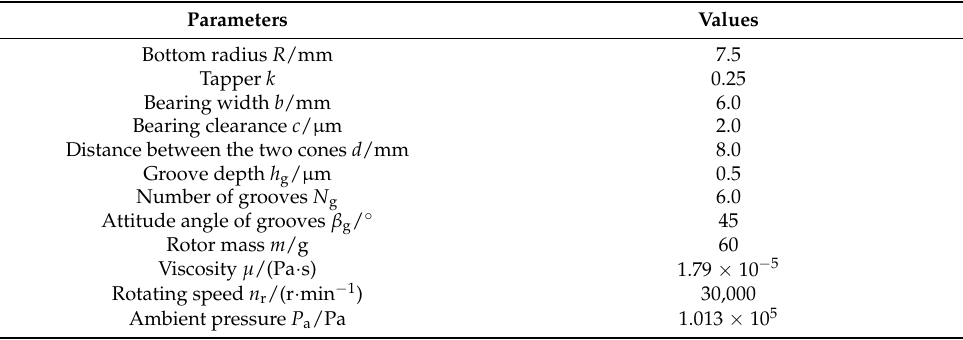
Table 1. Parameters for calculation of the gas-dynamic bearing gyroscope.